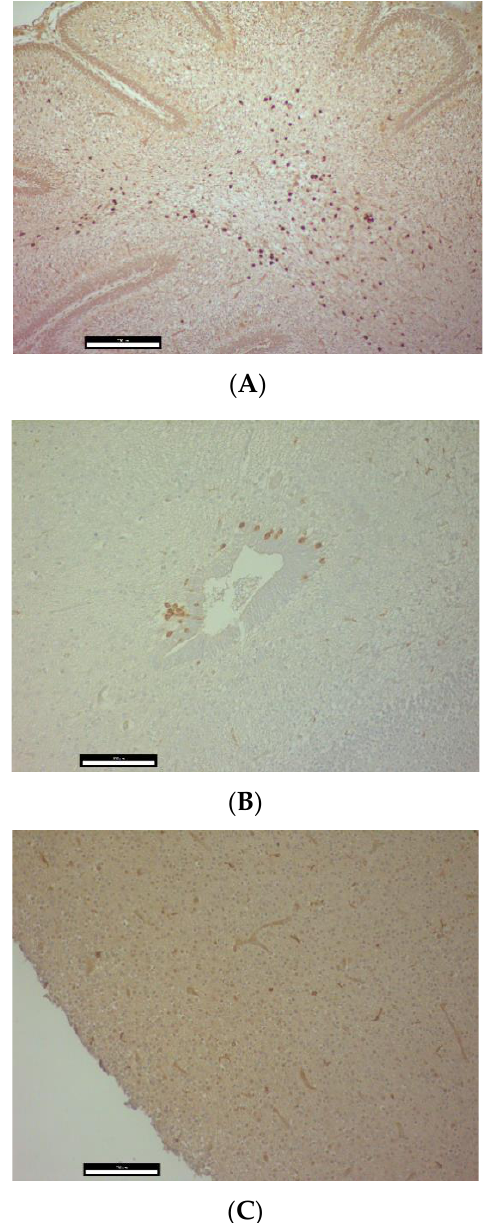
Figure 3. Parrot bornavirus 4 (PaBV-4) antigen detection in the brain of trial B embryos. ( A ) Cerebellum with PaBV antigen-positive brain cells, DAB staining in the arbor vitae (embryo DAB_PABV-2_01, 100× total magnification, size bar 200 µm). ( B ) Cerebrum with ventricle, positive brain cells by DAB staining at the base of ependymal cells (Embryo DAB_PABV-4_DO01, 200× total magnification, size bar 100 µm). ( C ) Cerebrum without ventricle with only a few positive cells visualized by DAB staining (embryo DAB_PABV-2_01, 100× total magnification, size bar 200 µm). For group 1, there were significantly more PaBV antigen-positive cells in the cerebellum than the cerebrum without ventricles (U = 17.5, p = 0.01552). There was not a significant difference in the PaBV antigen distribution between the cerebellum and the cerebrum with ventricles (U = 47.5, p = 0.88076). There was a significantly higher number of PaBV antigen-positive cells in the cerebrum with ventricles than the cerebrum without ventri- cles (U = 16, p = 0.0114) (Figure 4). Figure 4. Parrot bornavirus (PaBV) antigen distribution in the brain of trial B group 1 (PaBV-4 inoc- ulation in the yolk sac). The y-axis shows the number of PaBV antigen-positive cells counted in one slide (200× total magnification). PaBV antigen was mainly found in the cerebellum and cerebrum with ventricles, and much less frequently in the cerebrum without ventricles. The x-axis shows each individual embryo ( n = 10, laboratory number).